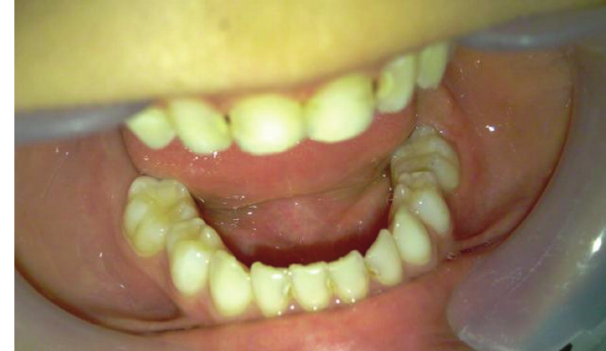
Figure 5: Restored tooth with resin composite.